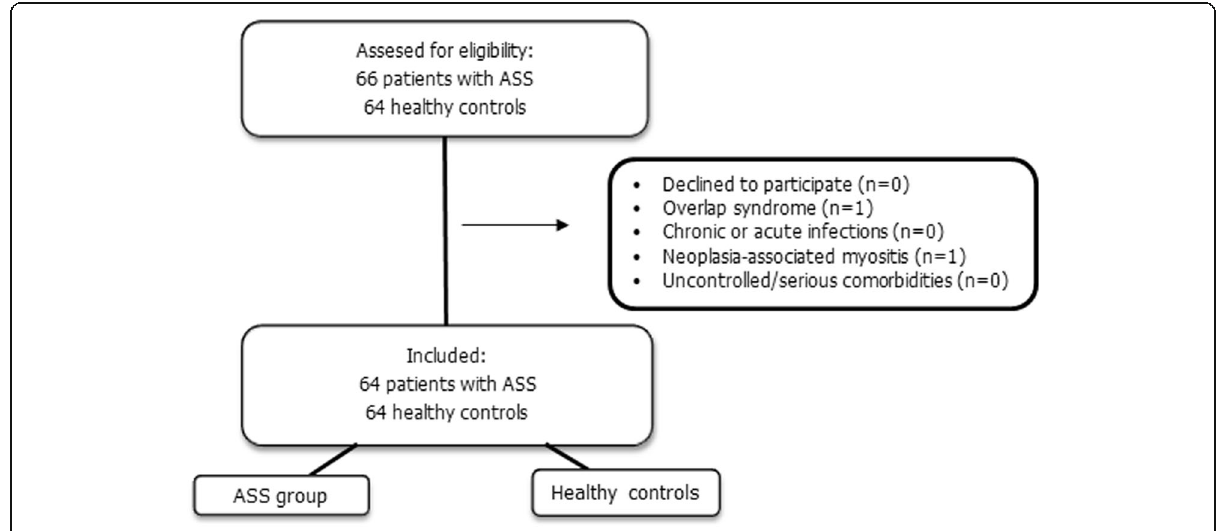
Fig. 1 Study flowchart. ASSD: antisynthetase syndrome